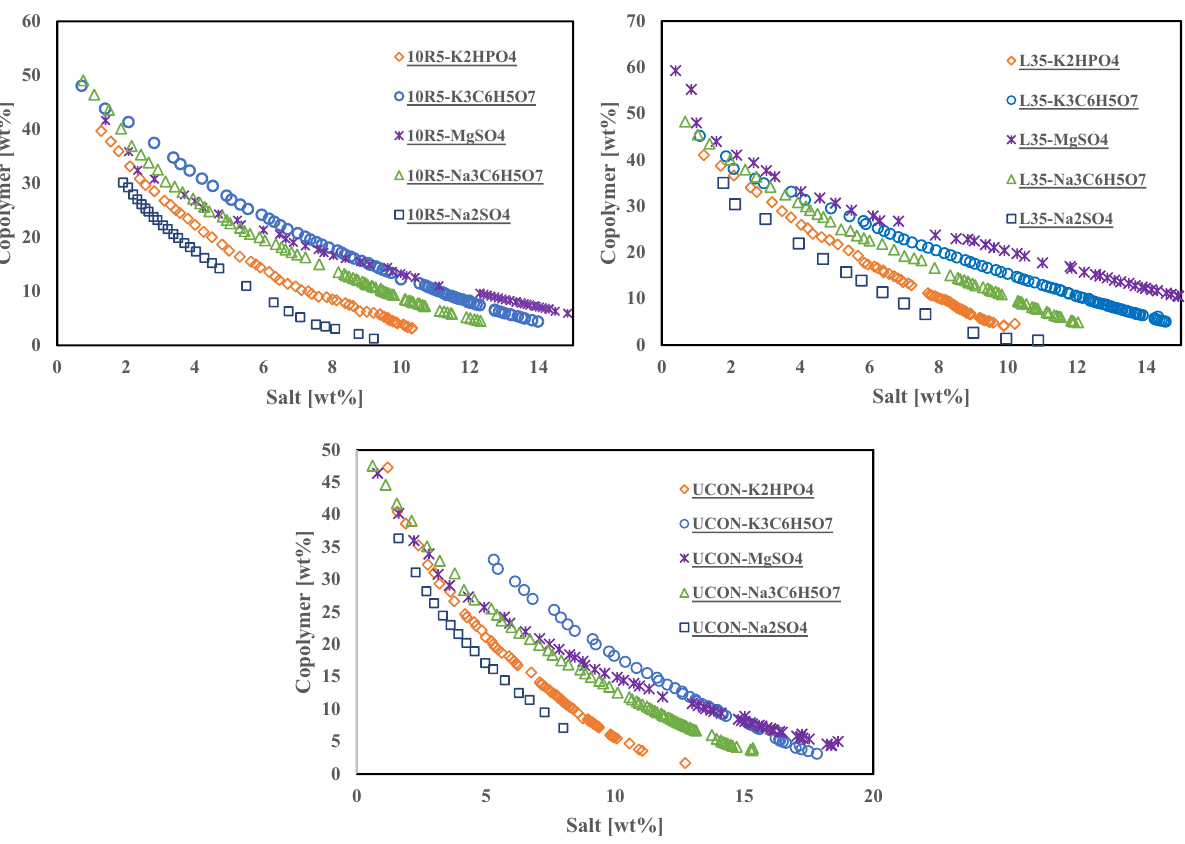
Figure 3. Experimental binodal curves determined for the ATPSs composed of different copolymer + salt at 283